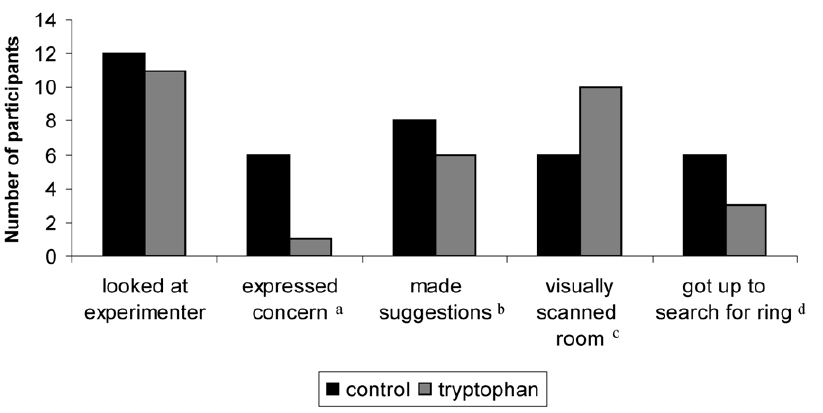
Figure 4. Reaction to the lost ring incident. a Fisher’s exact test (p=0.07). b Fisher’s exact test (p=0.68). c Fisher’s exact test (p=0.07). d Fisher’s exact test